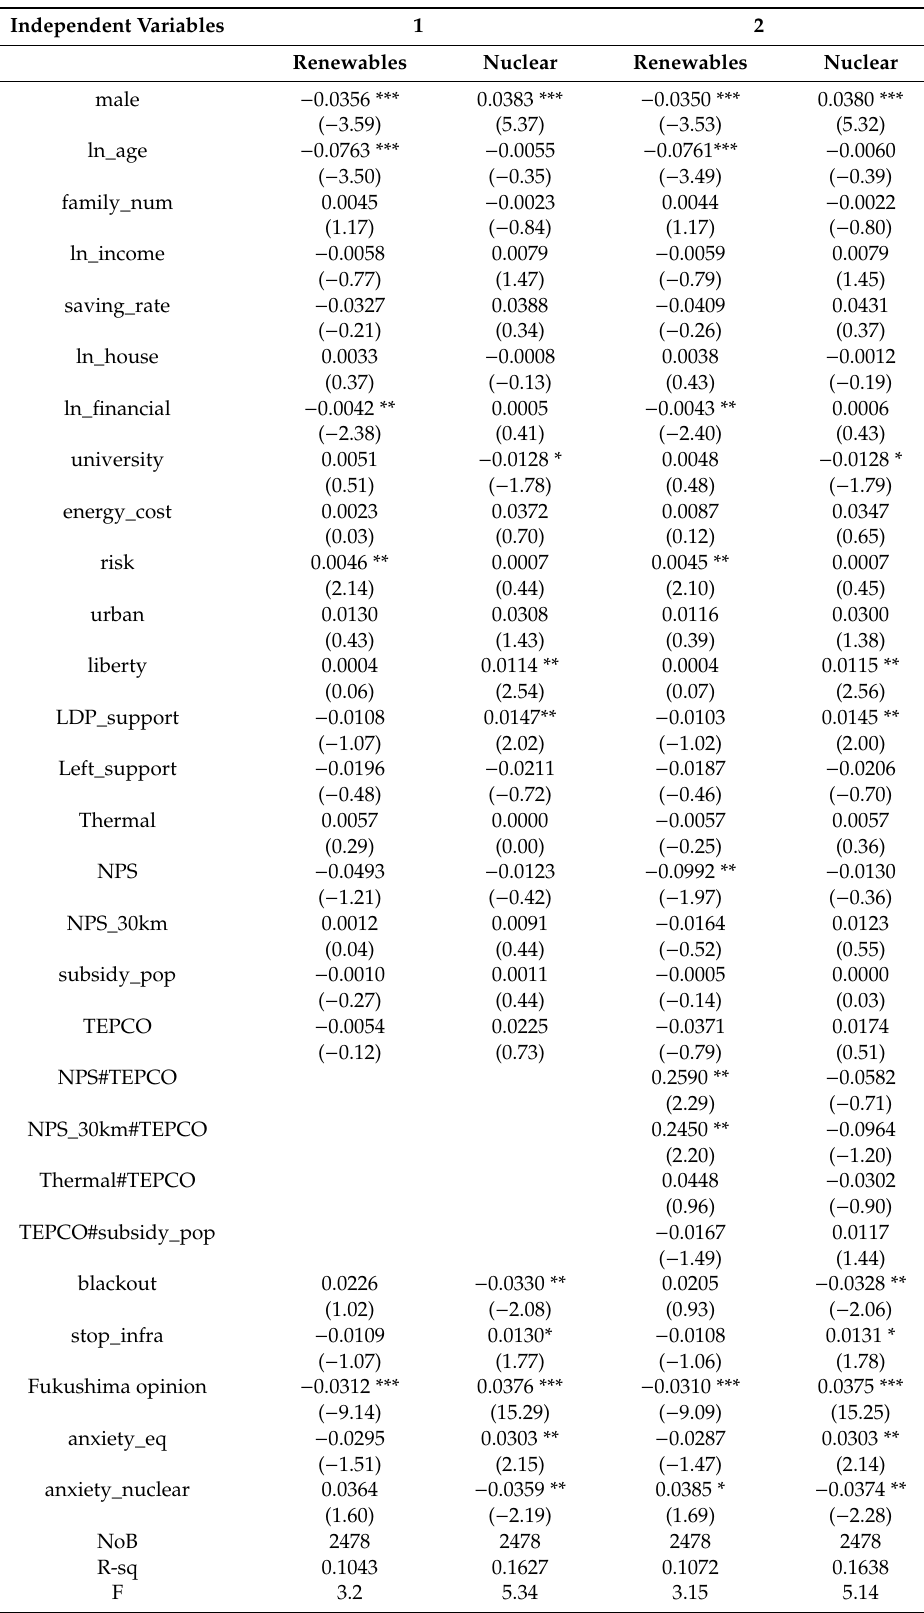
Table 3. Estimation result